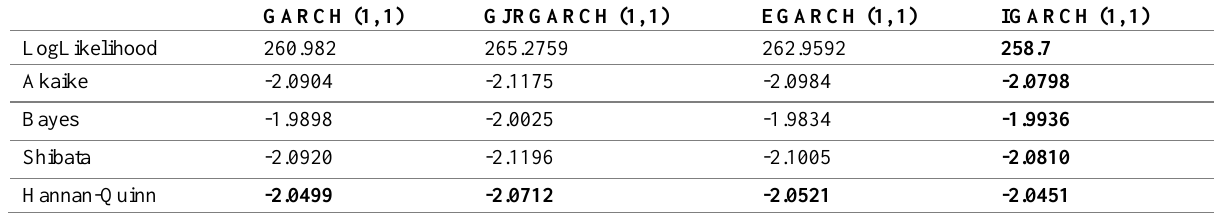
Table 4: Log likelihood and information criteria - student t